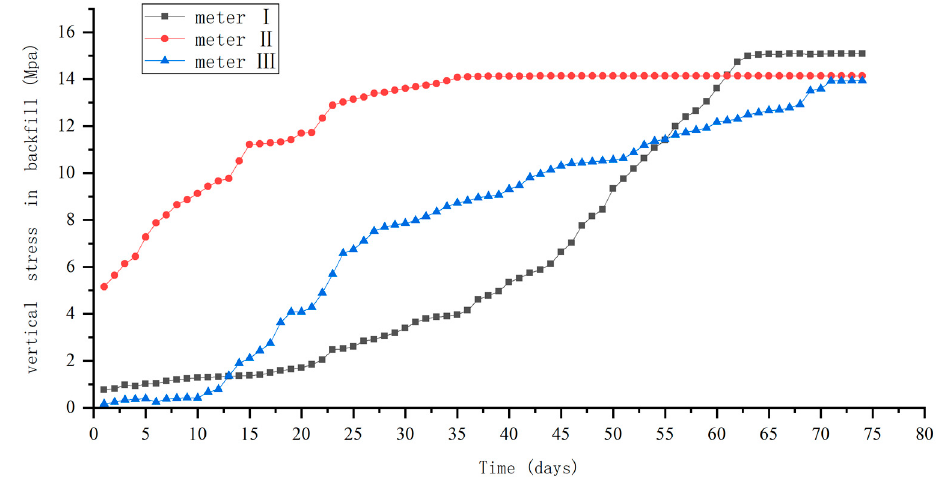
Figure 13. Variation of stress meter Ⅰ .